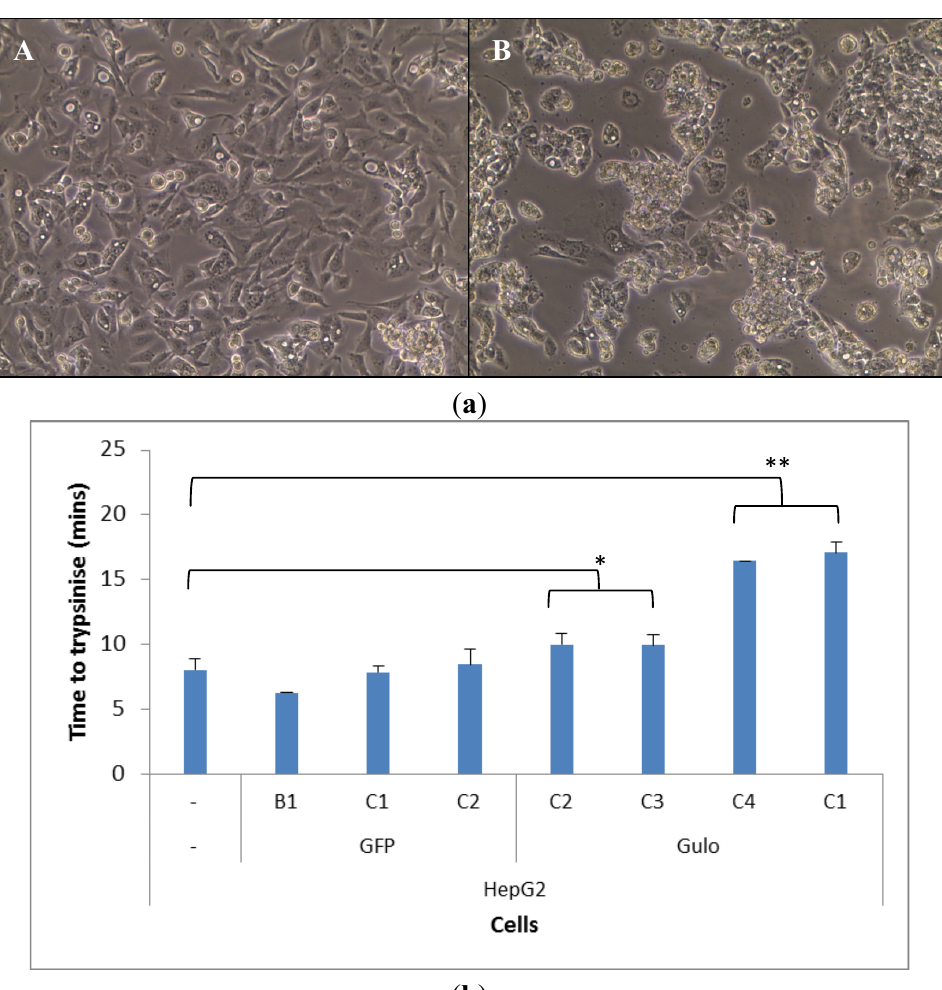
Figure 2. Morphology and adhesion of transfected HepG2 cells. ( a ) Microscopic view of HepG2 ( A ) and HepG2 GuloC1 ( B ) cells (200× magnification); ( b ) Time for trypsinisation of HepG2 cell lines; n = 5, mean ± SD, t -test (two tailed unpaired) (* p < 0.05, ** p <